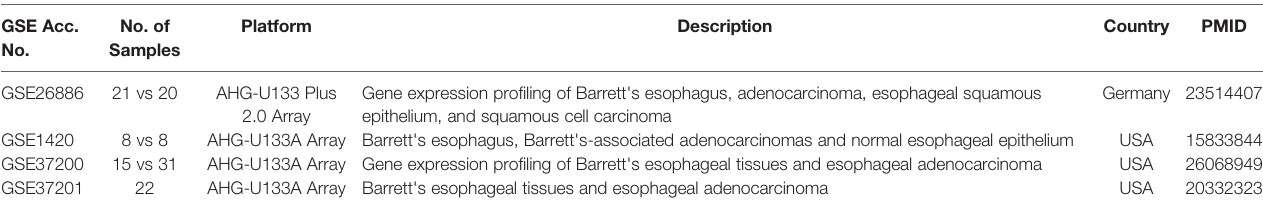
TABLE 1 | Relevant information about selected microarray datasets. GSE Acc.